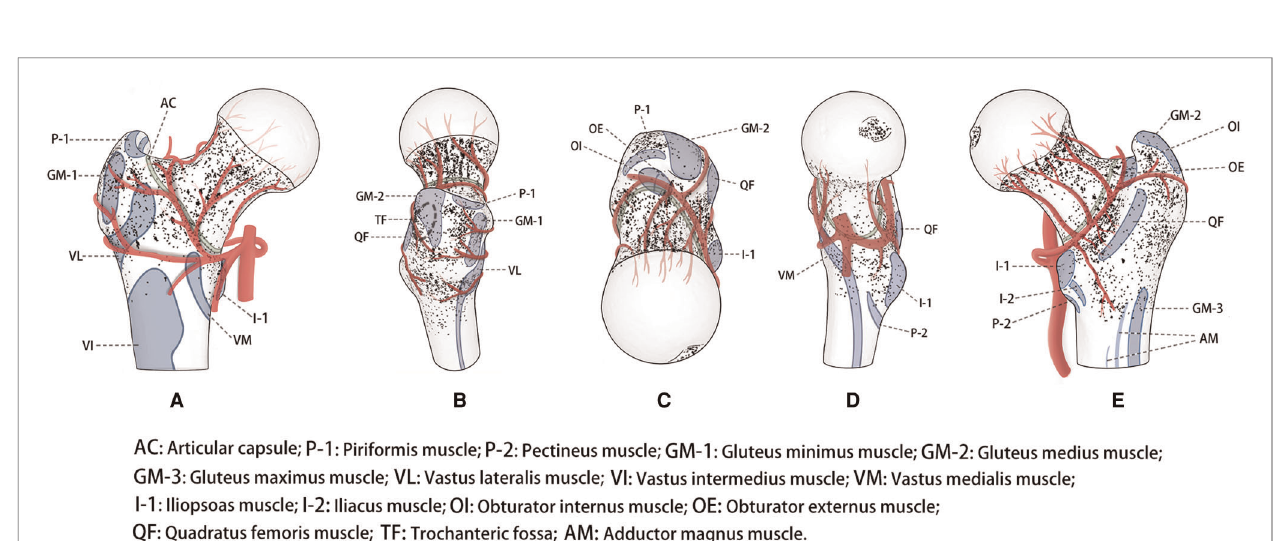
FIGURE 2 | Representative views of location-dependent distribution of the nutrient foramina in the proximal femur with anatomical landmarks, including anterior, lateral, superior, medial and posterior views. The nutrient foramina (Points) clustered, suggested dense